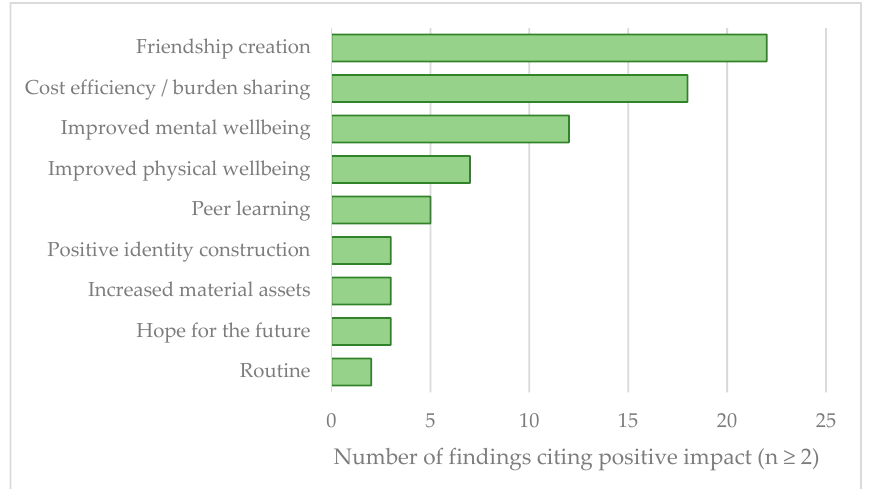
mental and physical wellbeing and personal circumstances. Figure 4 illustrates the key positive impacts reported in the data.